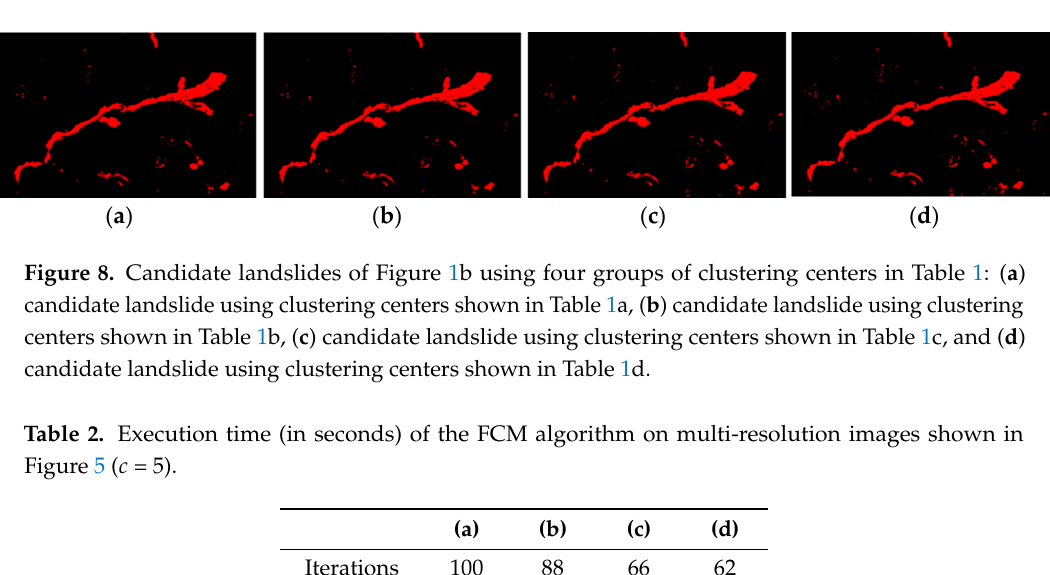
Table 2. Execution time (in seconds) of the FCM algorithm on multi-resolution images shown in Figure 5 ( 𝑐 = 5).